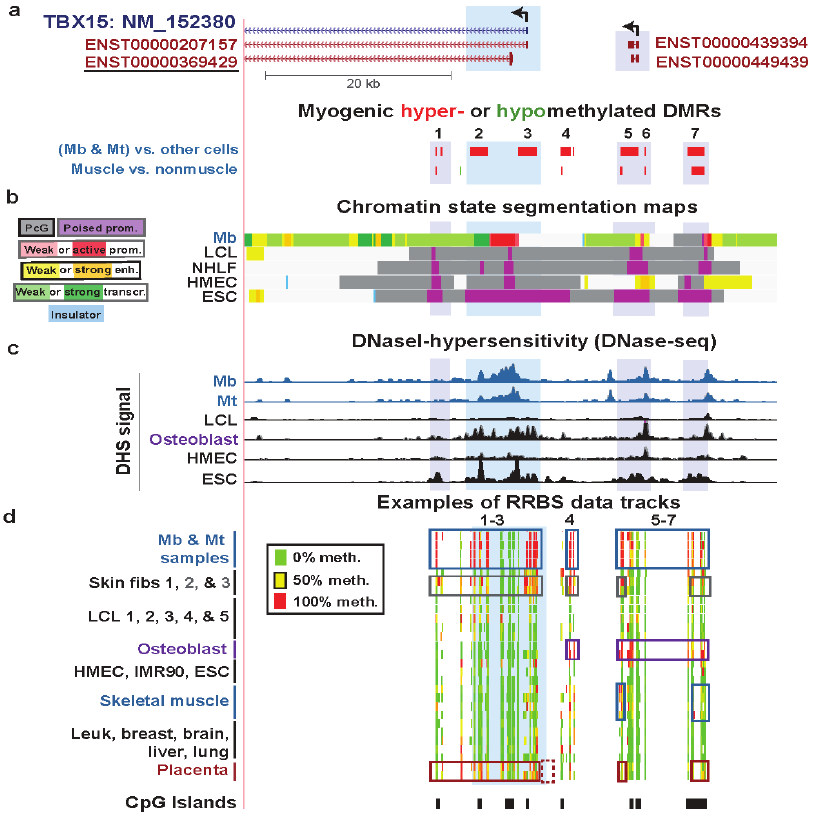
Figure 4. Association of hypermethylated myogenic DMRs with boundaries of active promoter-like chromatin in TBX15 and further upstream. ( a ) The underlined ENSEMBL isoform is the one that the RNA-seq data supports for Mb and Skin fibroblast 2 (foreskin fibroblasts; Figure 3). MbMt-hypermethylated DMRs (red) and one hypomethylated DMR (green) are indicated. The hypermethylated DMRs or clusters of DMRs are numbered for reference in the text. ( b ) Chromatin state segmentation analysis as in Figure 2. ( c ) DNaseI hypersensitivity signal (ENCODE/Open chromatin by DNaseI HS/Duke University [17,32]). ( d ) Examples of RRBS data tracks for the indicated samples as in Figure 3 but for a larger region (chr1:119501896-119558791). The dotted box at the bottom shows a region previously studied for DNA methylation in placenta by Chelbi et al . [55], as described in the